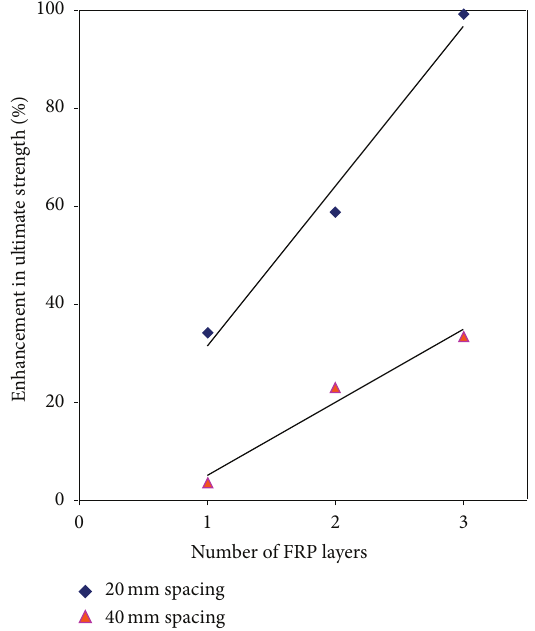
Figure 19: Relation between enhancement in ultimate strength and number of CFRP